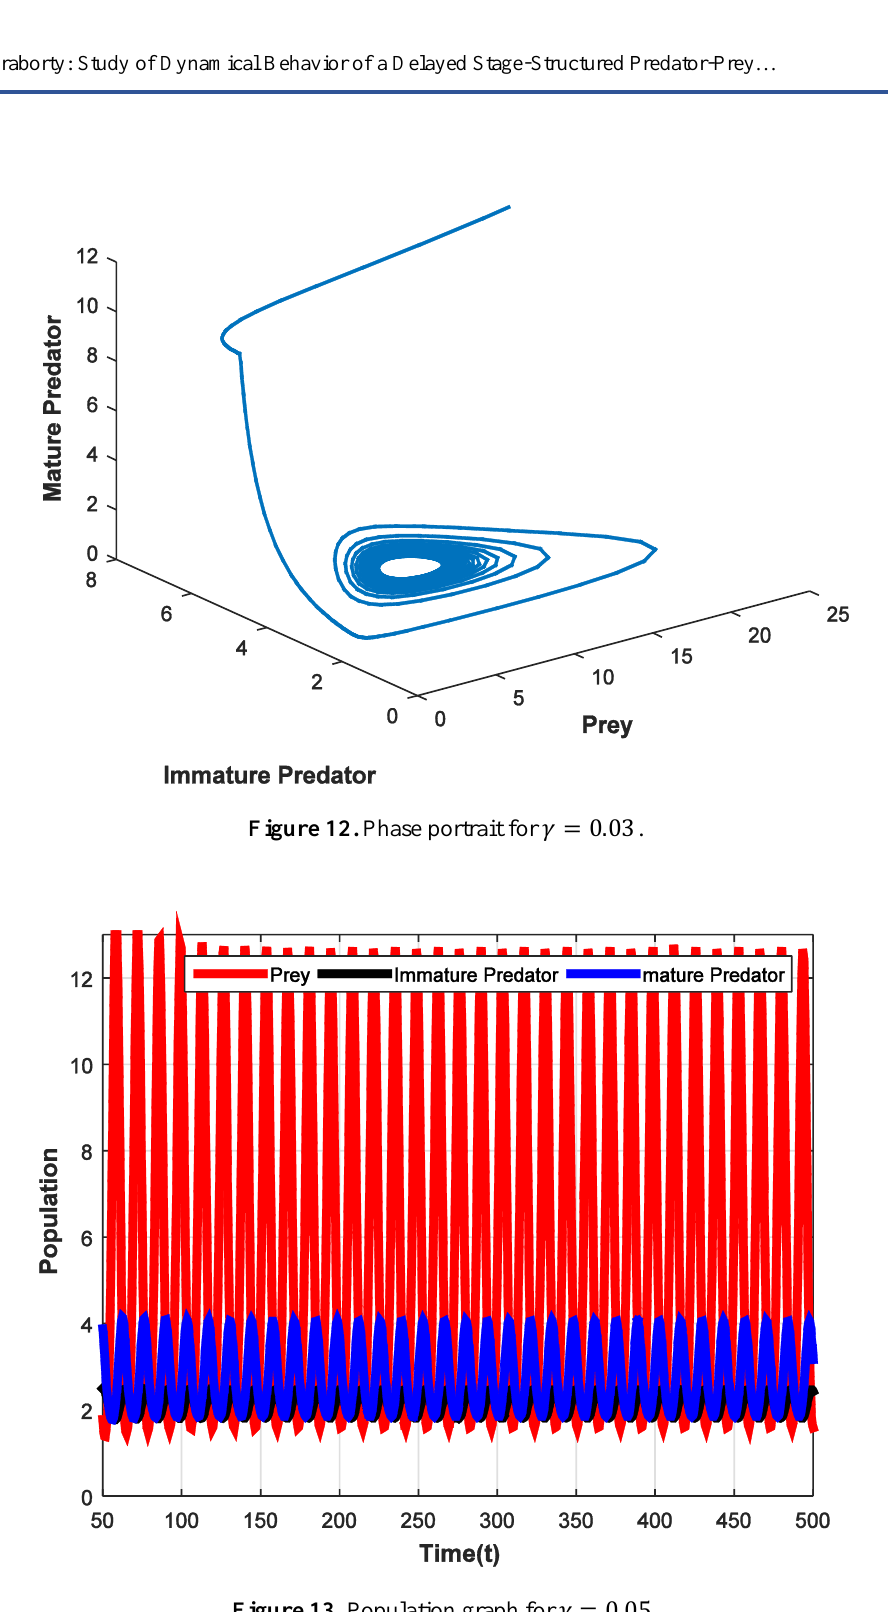
520 | Vol. 7, No. 4, 2022